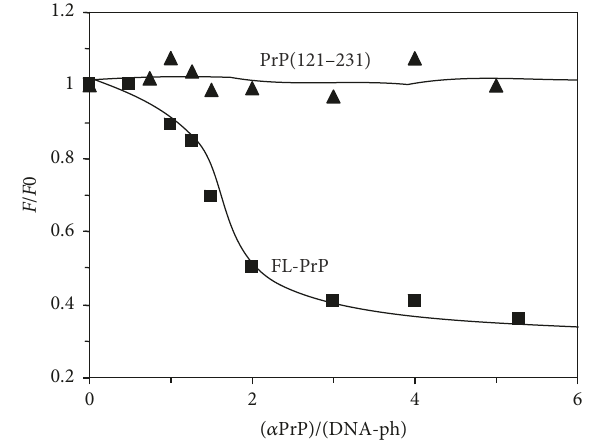
Figure 5: Comparison of the effects of 𝛼 -PrP (trace (a)) and C- terminal PrP 121–231 fragment (trace (b)) on the fluorescence prop- erty of YOYO intercalated in mDNA. 𝐹 0 and 𝐹 are the fluorescence intensities of the dye in the presence of DNA before and after the addition of protein, respectively, in 20 mM Hepes buffer, pH 7.4 containing 100mM NaCl. Dye to DNA-phosphate 1: 50. Excitation 485 nm; emission 505 nm. Temperature 20 ∘